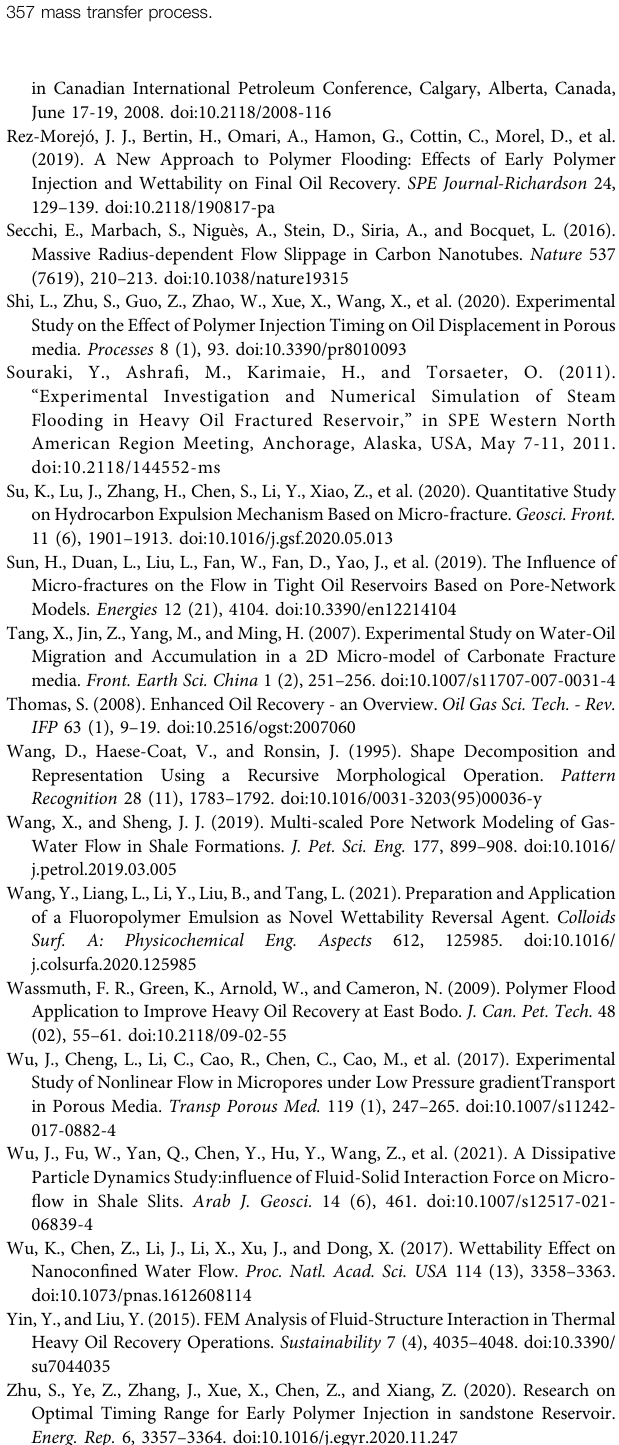
Supplementary Figure 2 | Comparison of capillary force curves under different wettability 318 conditions. SupplementaryFigure3| Comparisonofrelativepermeabilityindifferentwatercutstages. Supplementary Figure 4 | Comparison of capillary force curves at different 335 water cut